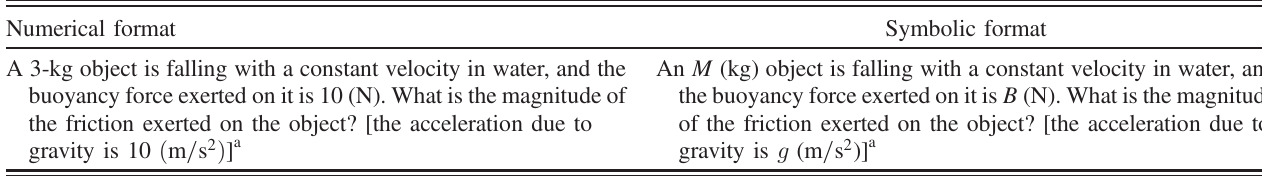
TABLE I. An example problem in the numerical and symbolic formats. Numerical format Symbolic